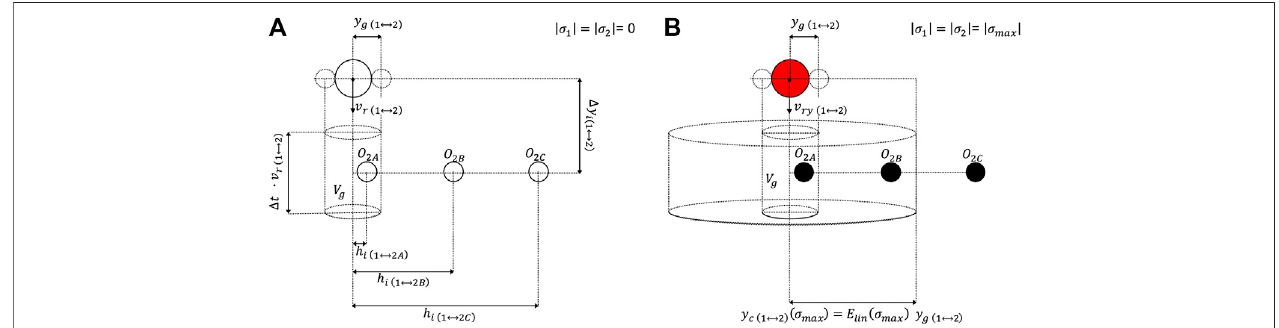
FIGURE 1 | Binary collisions between settling objects of different size: (A) neutral objects; (B) objects charged at the ionization limit. In all the Figures, O 2A , O 2B represent three possible positions of the object O 2 ; y g and y c represent the geometrical and the critical distance respectively; Δ y i represents the initial vertical offset betweenthe objects, and h i representstheinitial horizontaloffset; v r is therelative velocitybetween the objects which isthe settling velocity ofO 1 inthe reference system jointed to O 2 .